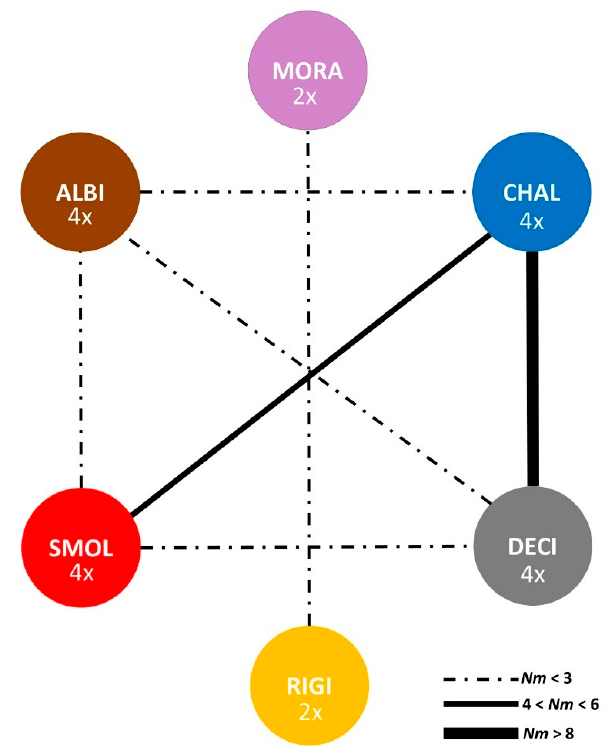
Figure 7. Levels of gene flow estimated as number of migrants (Nm) between the four tetraploid and two diploid Albanian taxa of Odontarrhena ; thickness of the lines connecting the species is proportional to the estimated level of gene flow; dotted and solid lines indicate Nm values < 3 (non-significant) and > 3 (significant), respectively; taxon name abbreviations are as in Figure